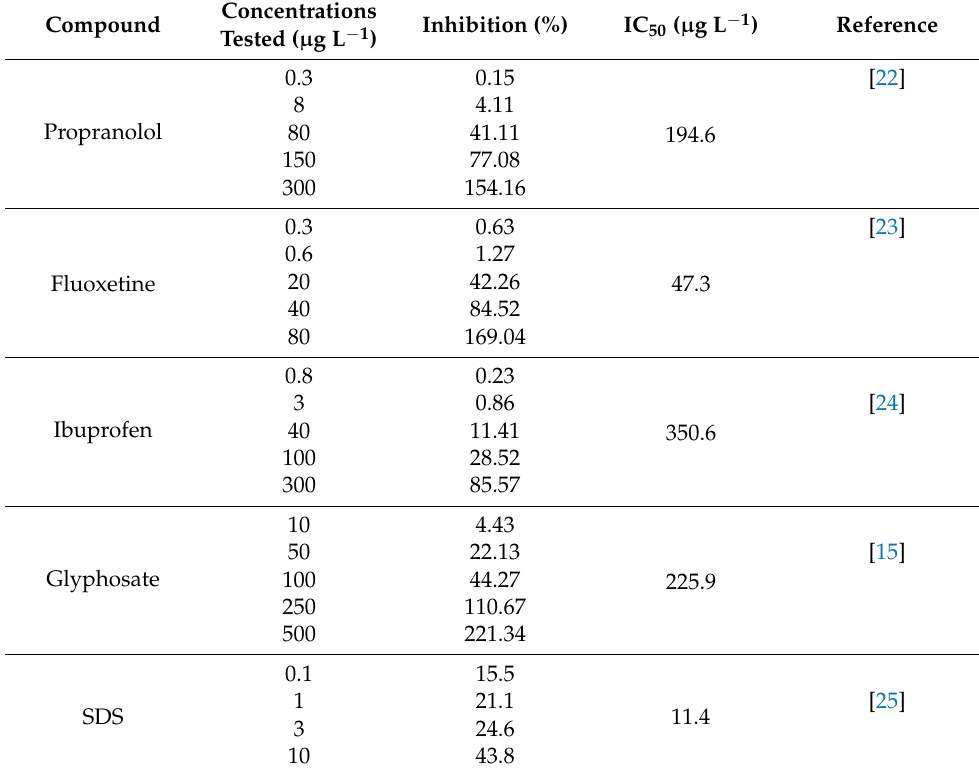
Table 1. Exposure compounds concentrations, Phaeodactylum tricornutum relative growth inhibition and calculated IC 50